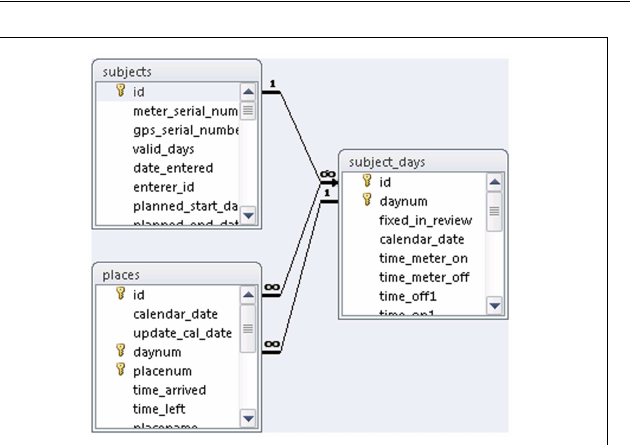
FIGURE 2 |Travel log database schema for data entry in Microsoft Access